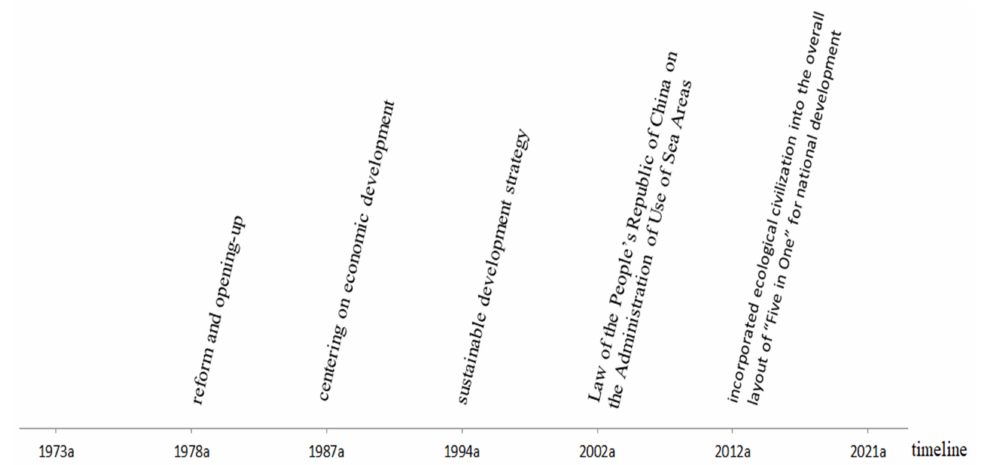
Figure 6. Key issues in the key years.